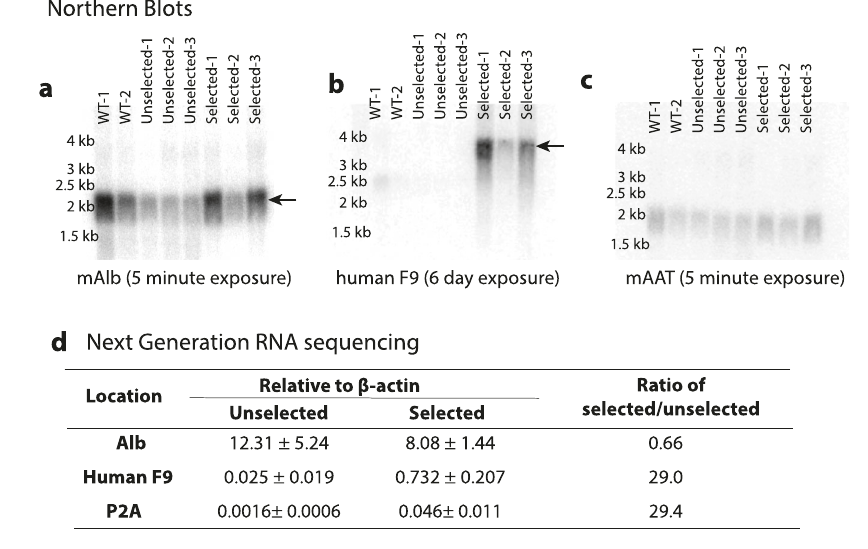
Fig. 3 | RNA analysis of GR-scgRNA treated mice. a – c Northern blotting of liver RNA from untreated wildtype (WT) mice ( n =2) or mice that recieved GR- Cypor scgRNA rAAV with ( n =3) or without ( n =3) APAP selection. a Albumin (mAlb), b human F9, and c Alpha-anti-trypsin (mAat). Each lane represents liver homo- genate from one mouse. d Table of gene expression from next generation RNA